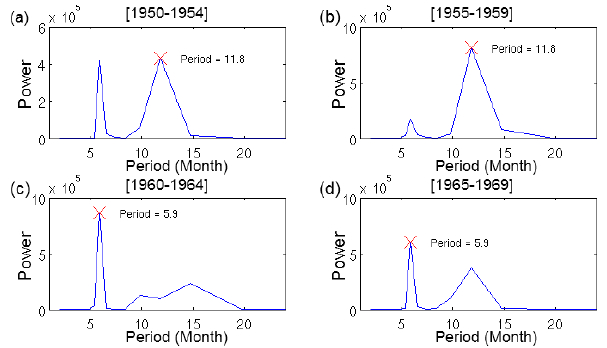
Fig. 21. Periodicities around 1960 in Naivasha estimated from the representative time series of the harmonics. (a) shows the period- icities between 1950 and 1954, (b) between 1955 and 1959, (c) be- tween 1960 and 1964, and (d) between 1965 and 1969. The red cross mark means the major periodicity in each time region.